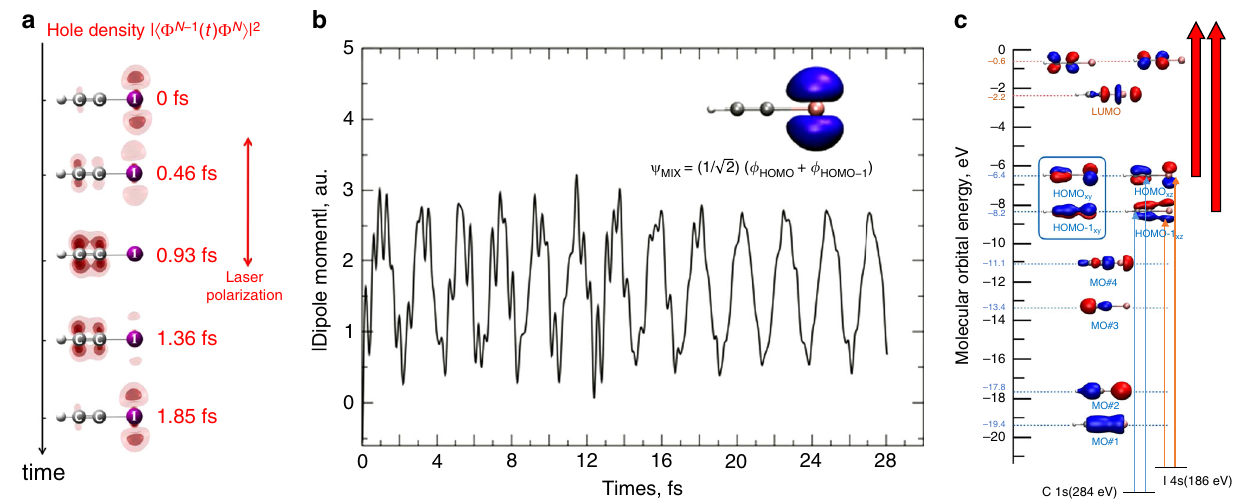
Fig. 3 Charge migration in molecules. a The reconstructed electron – hole density from HHG spectroscopy as a function of time after strong- fi eld ionization of HCCI. Reproduced from ref. 71 with permission from AAAS. b Dipole moment oscillations of C 2 HCI + ionized from a HOMO/HOMO-1 superposition of states. Reproduced from ref. 79 (2017), AIP. c Charge migration measured using attosecond X-ray transient absorption. The mixed hole state in C 2 HI + is formed by strong- fi eld ionization. The valence hole is probed by core-to-valence transitions. Adapted from ref. 79 (2017), AIP.